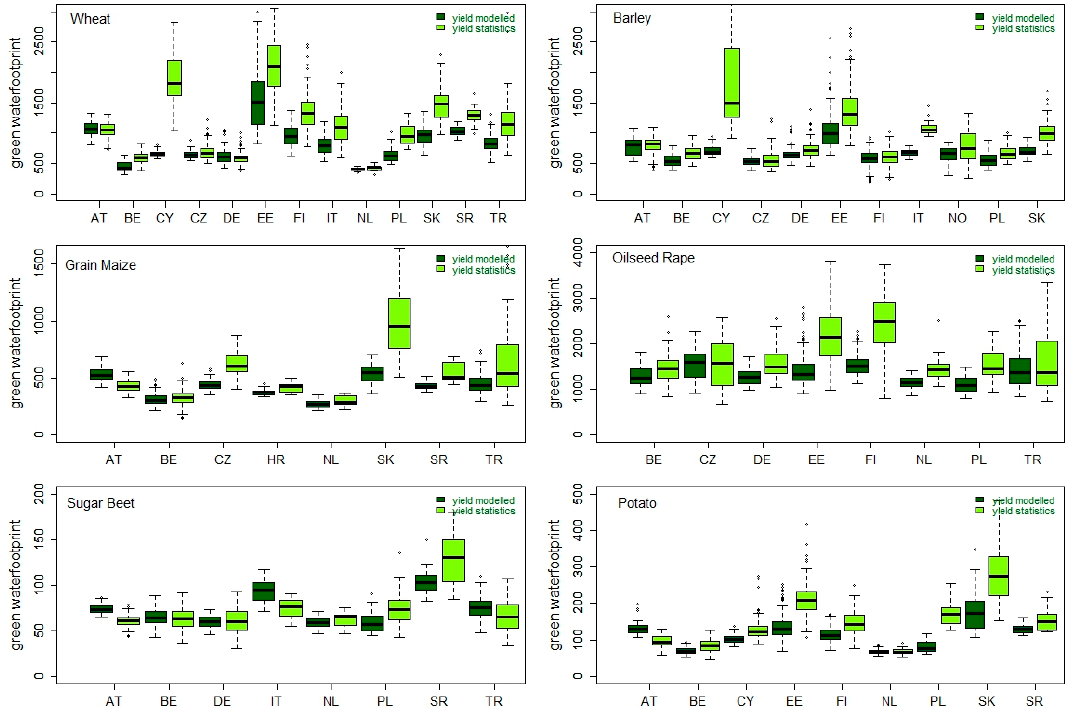
Figure 9. The green waterfootprint (in m 3 ∙ Mg − 1 ) for modelled and statistical arable yields across the European regions for the period 1992–2012. A two letter code refers to the country that the region belongs to.